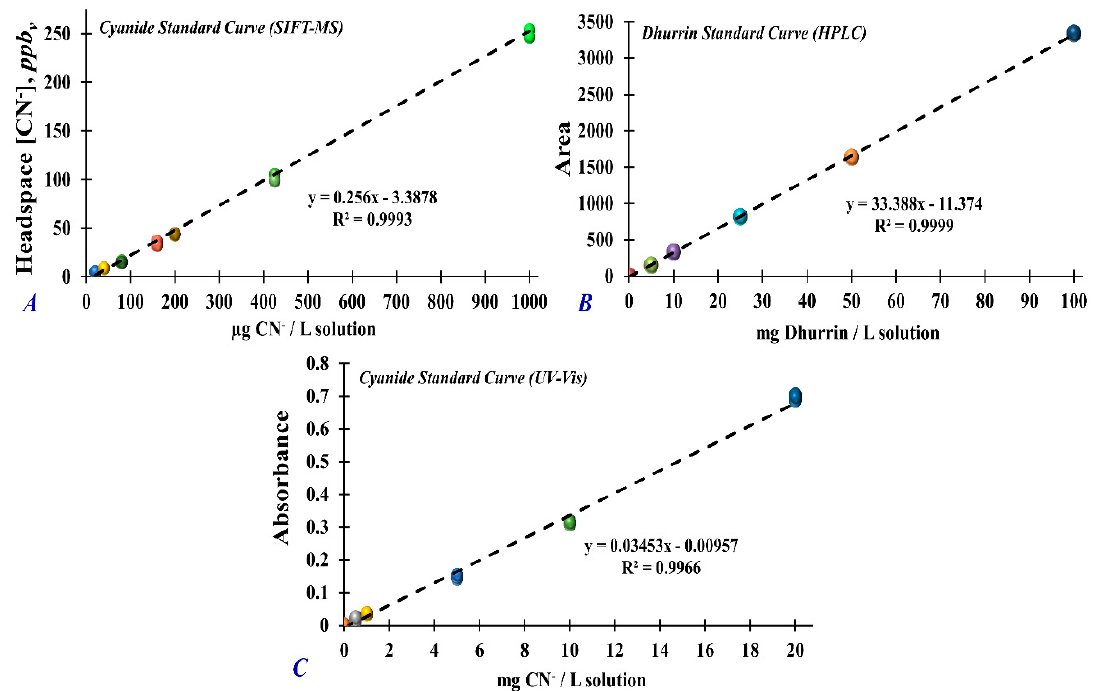
Figure 2. Standard calibration curve and linear regression analysis of ( A ) headspace cyanide concentration ( ppb v ) measured by selected ion flow tube–mass spectrometry (SIFT-MS) as a function of cyanide concentration in aqueous solution ( µ g / L); ( B ) peak area of dhurrin measured by HPLC-DAD (diode array detector) as a function of dhurrin concentration in aqueous solution (mg / L); ( C ) UV–vis spectral absorbance of cyanide standards as a function of cyanide aqueous solution concentration (mg / L). Linear regression analyses were performed at 95% confidence intervals.